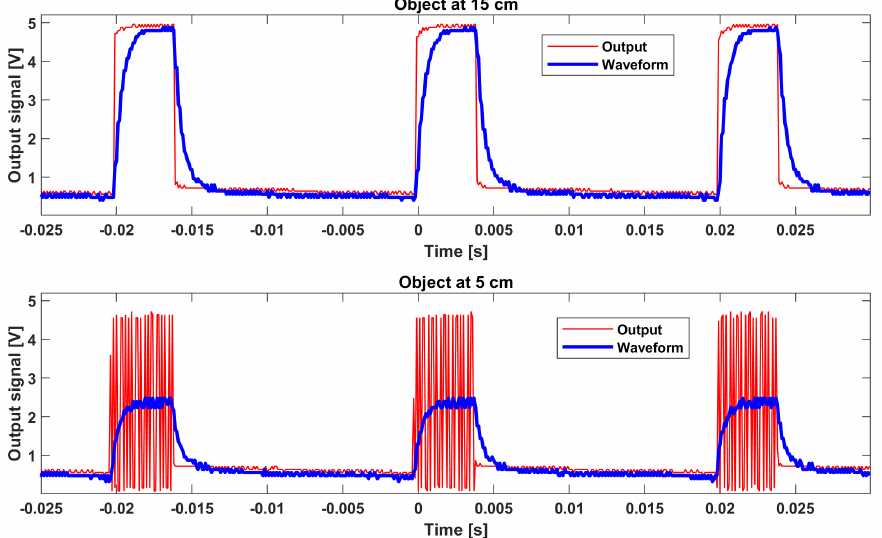
Figure 4. Voltages at the input (red) and output (blue) of the passive RC